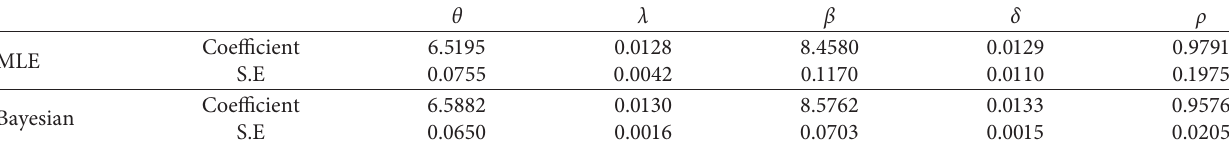
Table 7: MLE and Bayesian estimation for the BMEE distribution using the dataset.